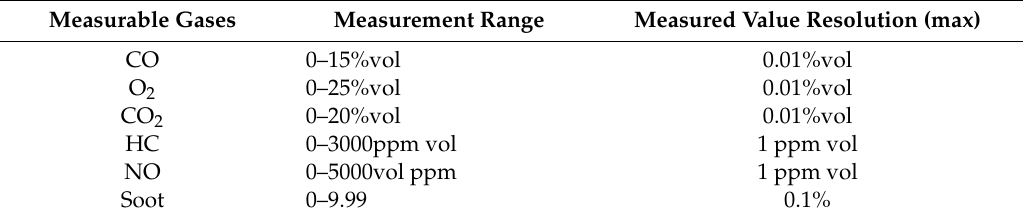
Figure 2. ( a ) Kubota V3300 combustion system [25]; ( b ) schematic of engine and dynamometer. Table 3. MAHA-MGT5 machine Table 2. Engine specifications of Kubota V3300.